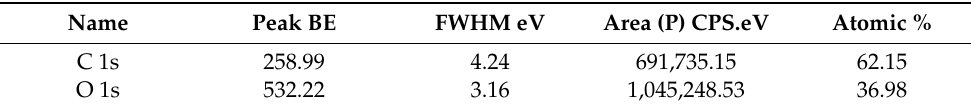
Figure 2. XPS ( a ) survey and deconvoluted ( b ) C1s, and ( c ) O1s spectra. Table 1. The atomic ratios of the elements present in the